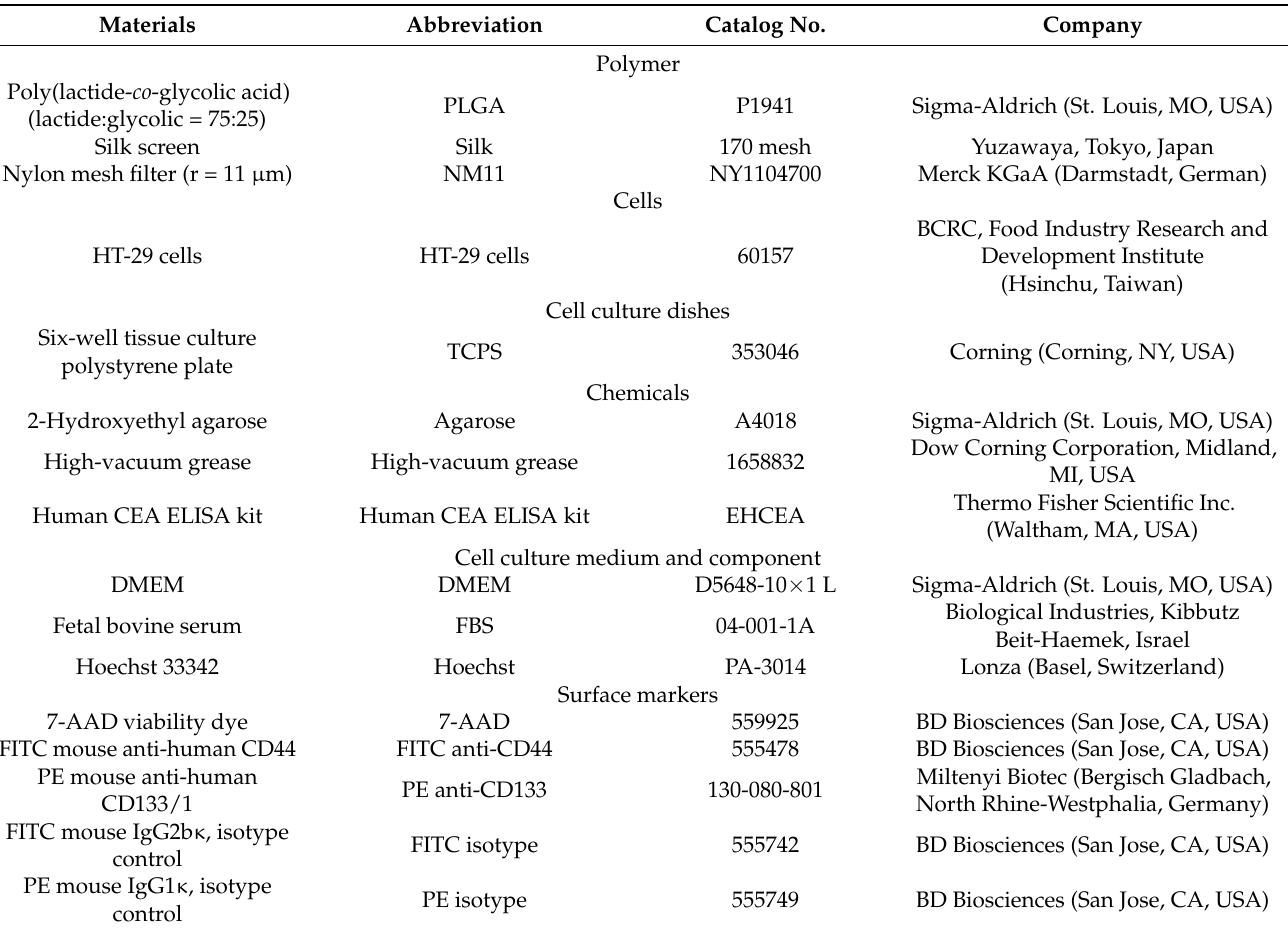
Table 1. Materials used in this